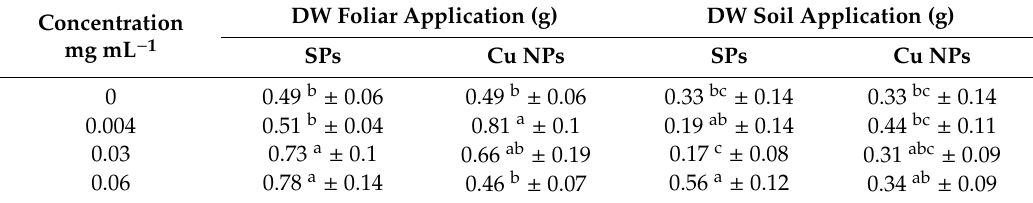
Table 6. E ff ect of SPs and Cu NPs on the dry weight of wheat in foliar and soil applications.